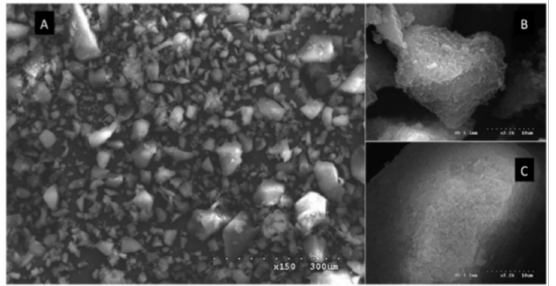
Figure 7. SEM microscopic images of crushed polymers produced by the bulk polymerization method. ( A , B ) shows the MIP particles, while ( C ) shows the NIP particles [74]. The morphology of MIPs that characterized by SEM via the suspension technique was discuss detailed by Liu et al. [85] to synthesis MIPs for the selective extraction